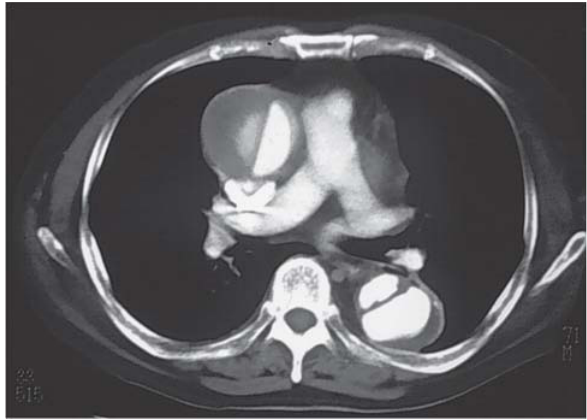
Fig. 1 - Tomografia computadorizada do tórax mostrando dissecção da aorta tipo A de Stanford em paciente no pós-operatório de cirurgia